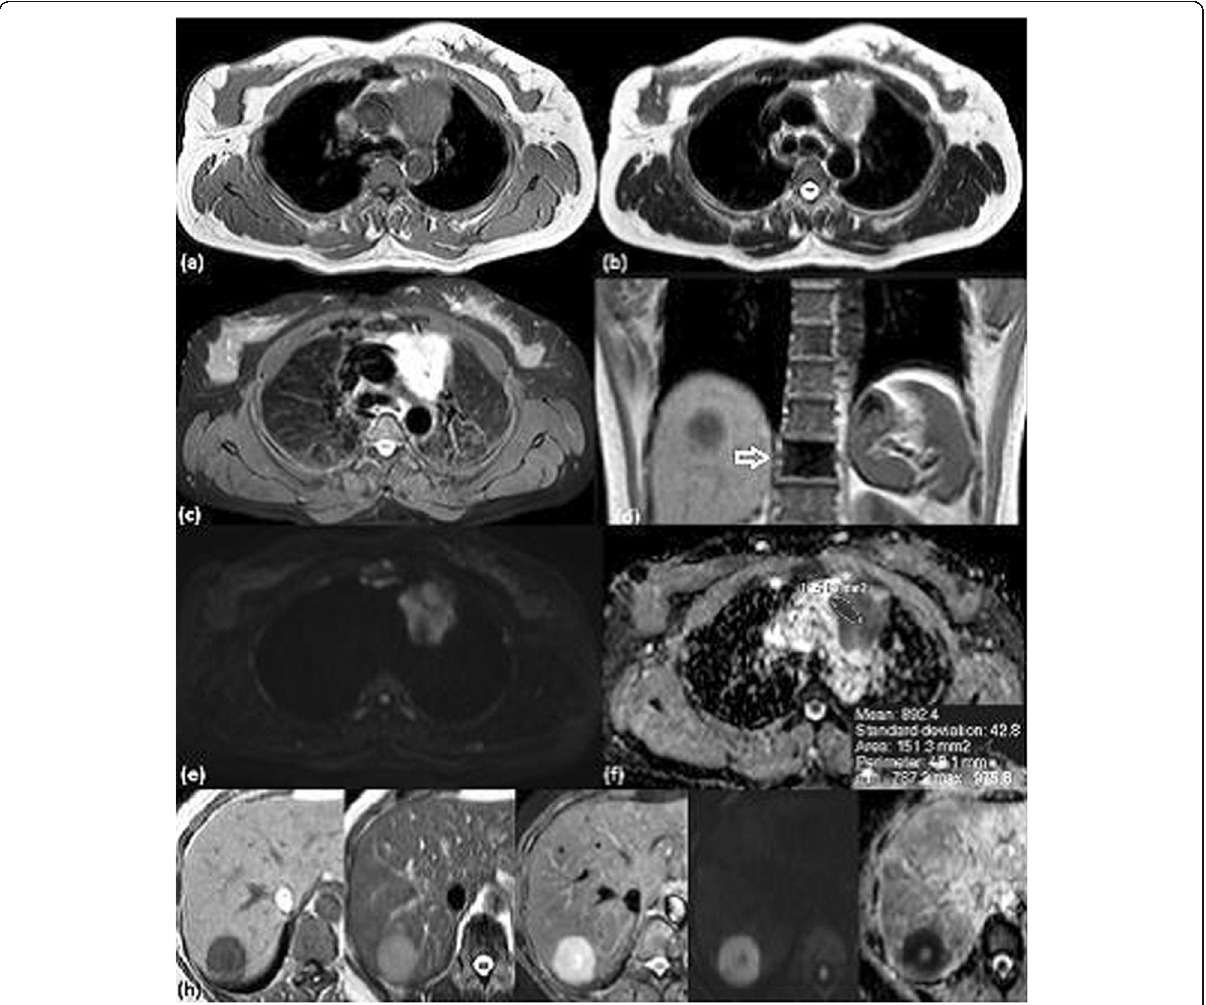
Fig. 1 Malignant B3 thymoma. A 42-year-old female patient clinically presenting with back and right upper limb pain underwent MDCT of the chest that revealed an anterior mediastinal mass. a Axial T1 WI, b axial T2 WI, and c axial STIR WI show a small well-defined oval-shaped anterior (prevascular) mediastinal mass displaying intermediate T1 and relatively bright T2 and bright STIR signal intensities. The lesion shows restricted diffusion by being bright on e DWI and dark on the f ADC map. ADC mean = 0.895 × 10 − 3 mm 2 /s and ADC min = 0.769 ×10 − 3 mm 2 /s. Associated findings: mid-dorsal sclerotic vertebra as seen on d coronal T1 WI; latter proven metastatic by bone scan. Right lobar hepatic focal lesion seen on h axial T1, T2, STIR and DWI and ADC map (from left to right) displaying low T1 and high T2 and STIR signal intensities with evident